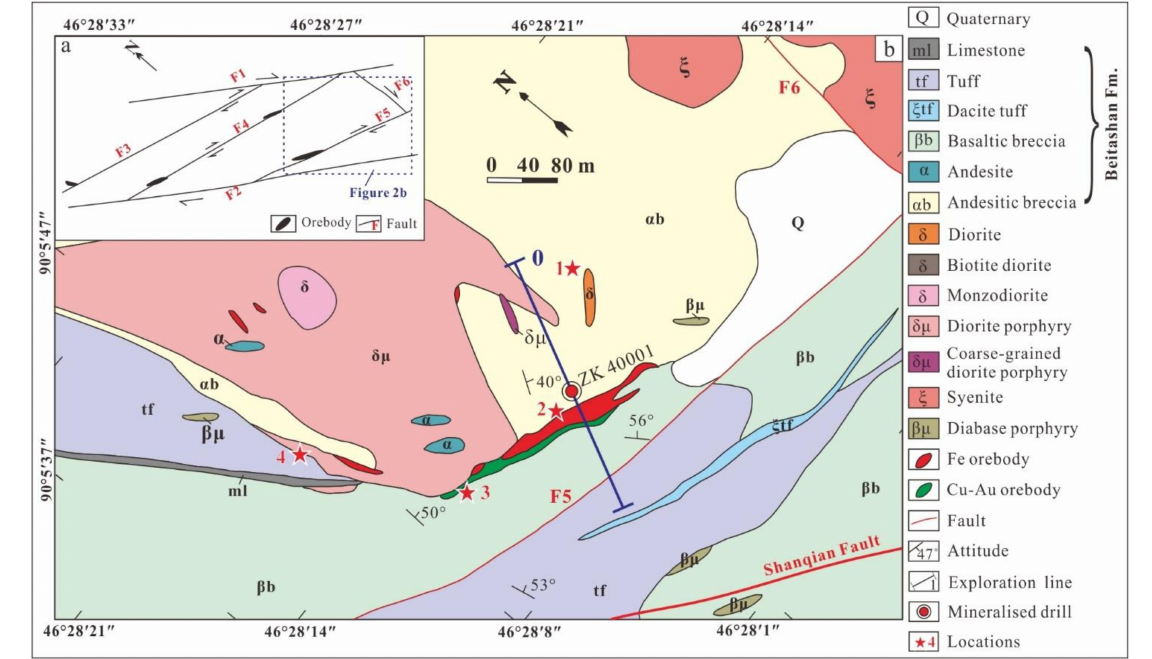
Figure 2. Structural map ( a ) and geologic map ( b ) of the Laoshankou deposit (modified from [29] and Xinjiang Geological Survey, unpublished). Abbreviations: F1, Fuyun Fault; F2, Shanqian Fault; F3, F4, F5, F6, unnamed secondary faults. Sample locations: 1, LS-024-2, LS-024-3; 2, No. 5 pit, LS-006; 3, Stock heap, LS-026, LS14-012-5, LS14-012-6, LS14-012-7; 4, TS-001, TS-001-7.